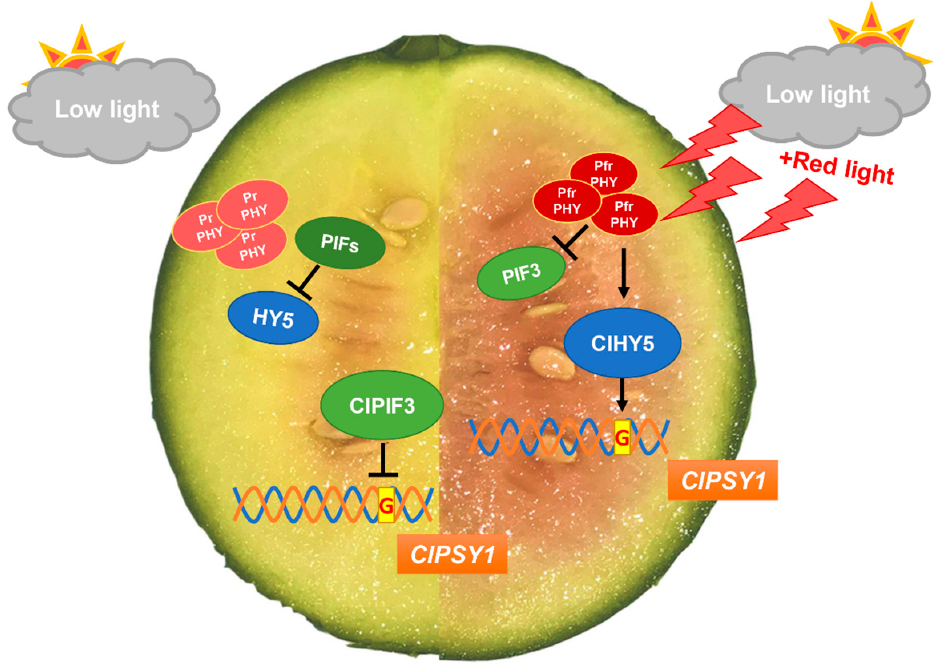
Figure 6. Model of ClPIF3 and ClHY5 cooperatively regulated the lycopene accumulated in water- melon flesh. Under low light, PHYs is present in the cytoplasm as inactive Pr form [47], PIFs protein abundance increased to promote the degradation of HY5 [48]. ClPIF3 inhibit ClPSY1 transcription by directly binding to the G-box cis -element on the promoter to inhibited lycopene accumulation in watermelon flesh. Under supplementary red lighting, PHYs as active Pfr form, PHYs induces rapid in vivo phosphorylation of PIF3 preceding degradation [14]. Red light also induced PHYs to pro- motes accumulation of HY5 proteins [49]. ClHY5 activated ClPSY1 transcription by directly binding to the G-box cis -element on the promoter to promoted lycopene accumulation in watermelon flesh.